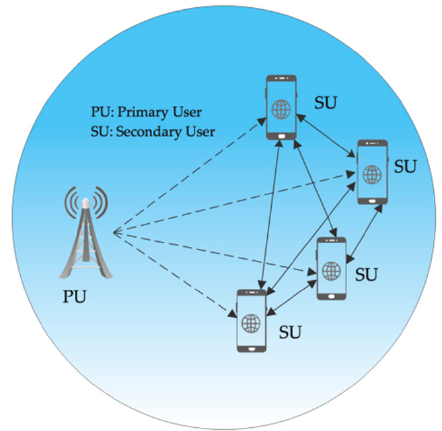
Figure 1. The system of cooperative spectrum sensing.